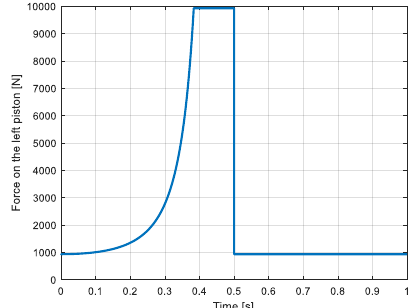
Figure 9. Force developed by the left piston (N).